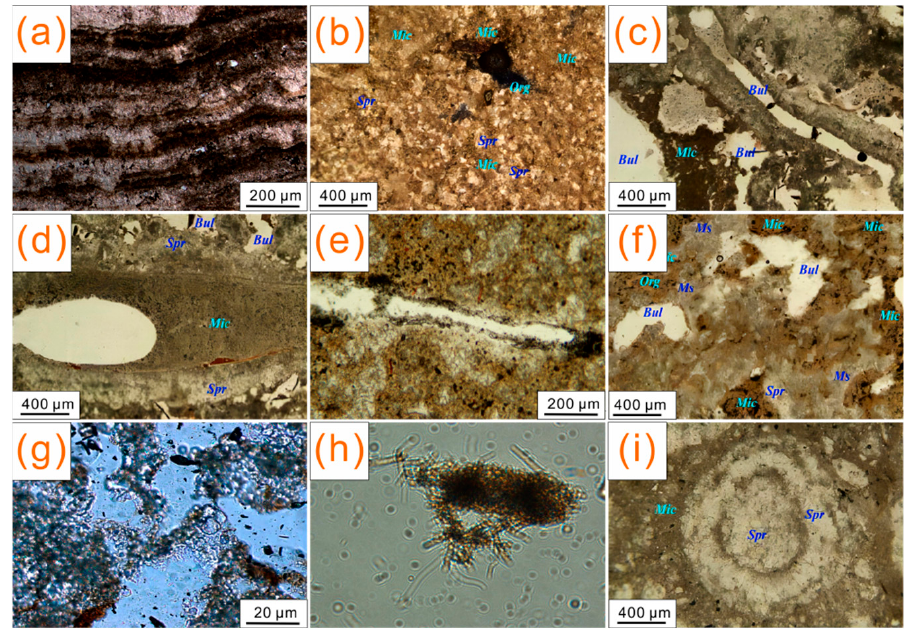
Figure 4. Thin-section results of Sparkling Lake calcareous tufa sample. ( a ) Lamellar limestone. ( b – d ) Surrounding the organic matrix distribution side is sparry calcite. ( e ) Calcite sparry and micrite around petiole. ( f ) Around the void with no living organisms involved. ( g , h ) Sparkling Lake red algae population. ( i ) Recrystallization forms sparry calcite. Spr = sparry, Mic = micrite, Ms = microspar, Org = organic.